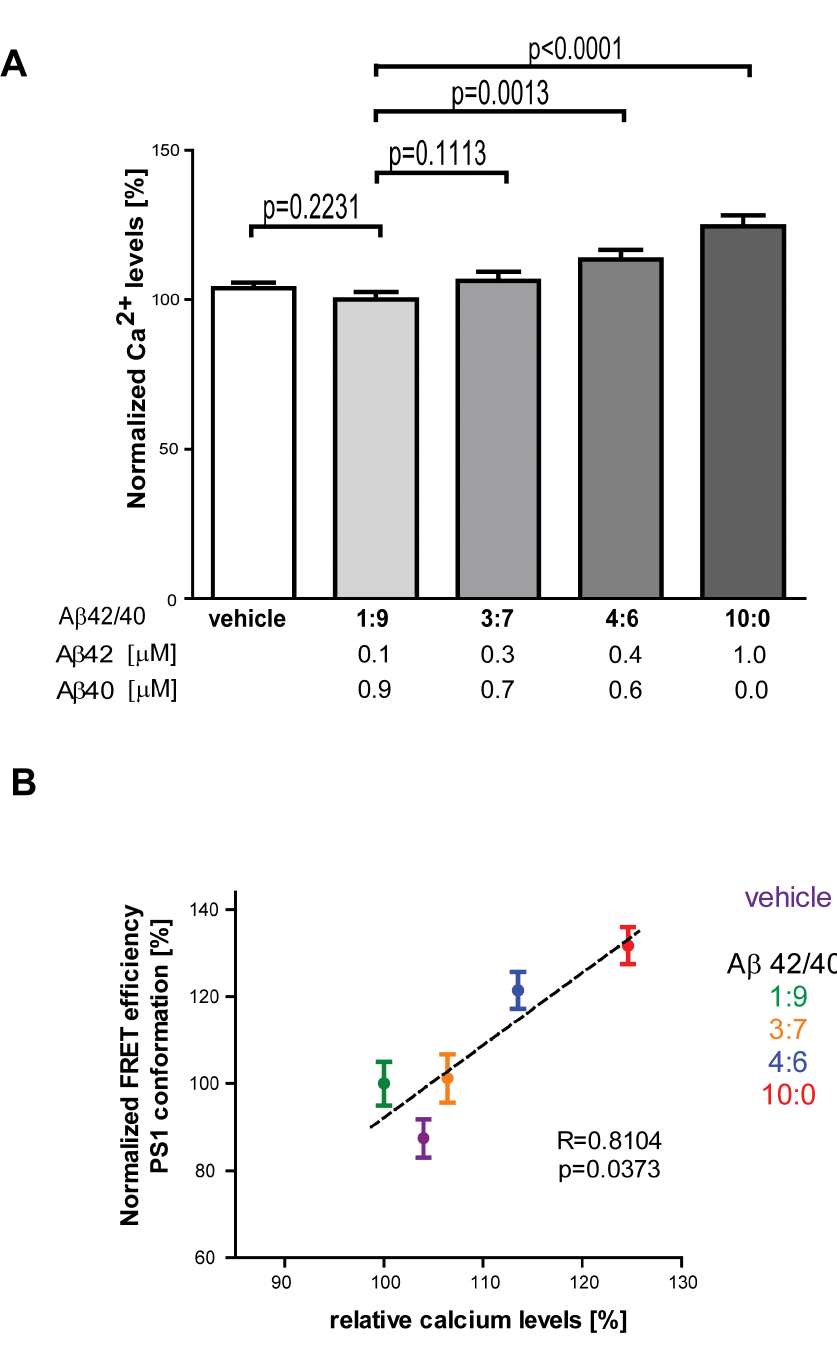
Figure 4. Intracellular calcium level upon A β treatment. (A) The relative levels of intracel- lular calcium in primary neurons were determined using ratiometric Indo-1 dye. The